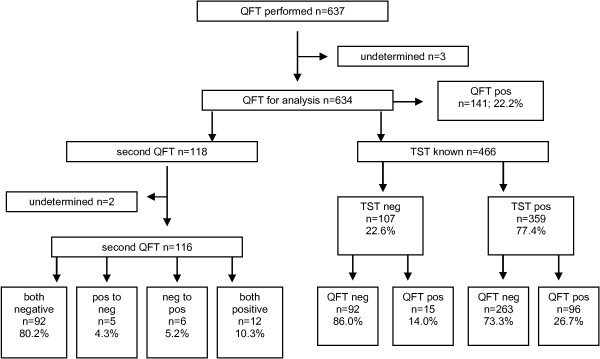
Flow chart of study population.